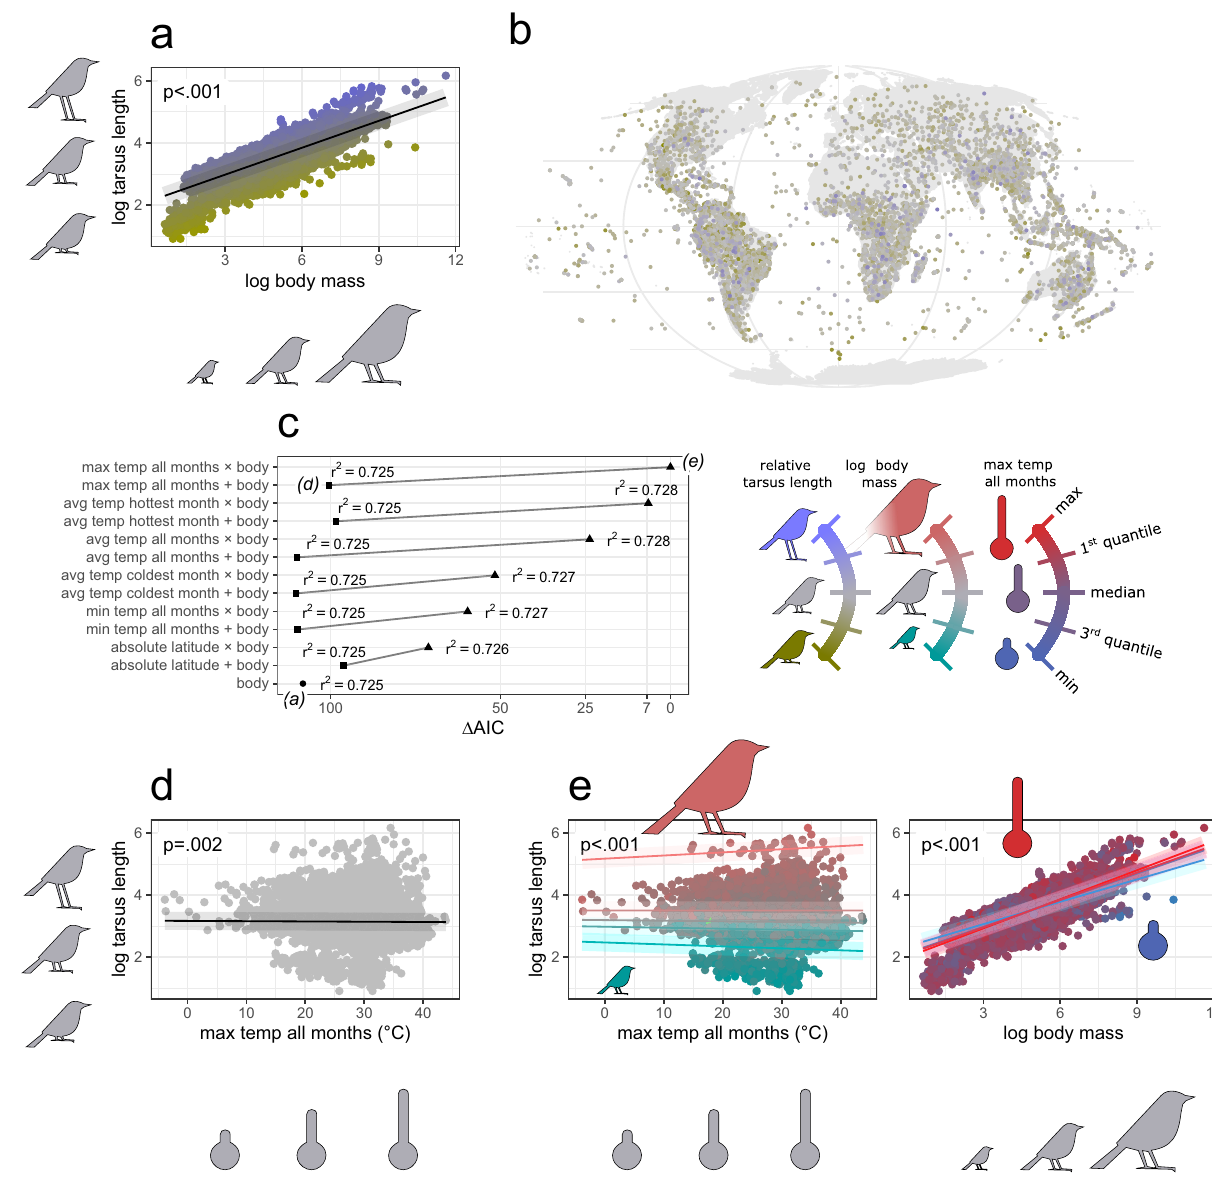
Fig.3|GlobaltestofAllen ’ sruleonaviantarsuslengthacross9962(99.7%)bird species. Thenullallometricmodel( a )usedtoscaletheabsolute(log-transformed) tarsuslength with log bodysize, the residualsfrom which wereusedasthe relative tarsus length. Distribution of relative tarsus length across species geographic ran- ges ( b ). Model selection procedure for predicting log tarsus length ( c ), involving models with log body mass and either of six temperature measures within species geographic ranges included as fi xed and interaction terms; AIC — Akaike Informa- tion Criterion, r 2 — coef fi cient of determination. An exemplar Allen ’ s model ( d ) showing decreasing tarsus length with max temperature of all months, while